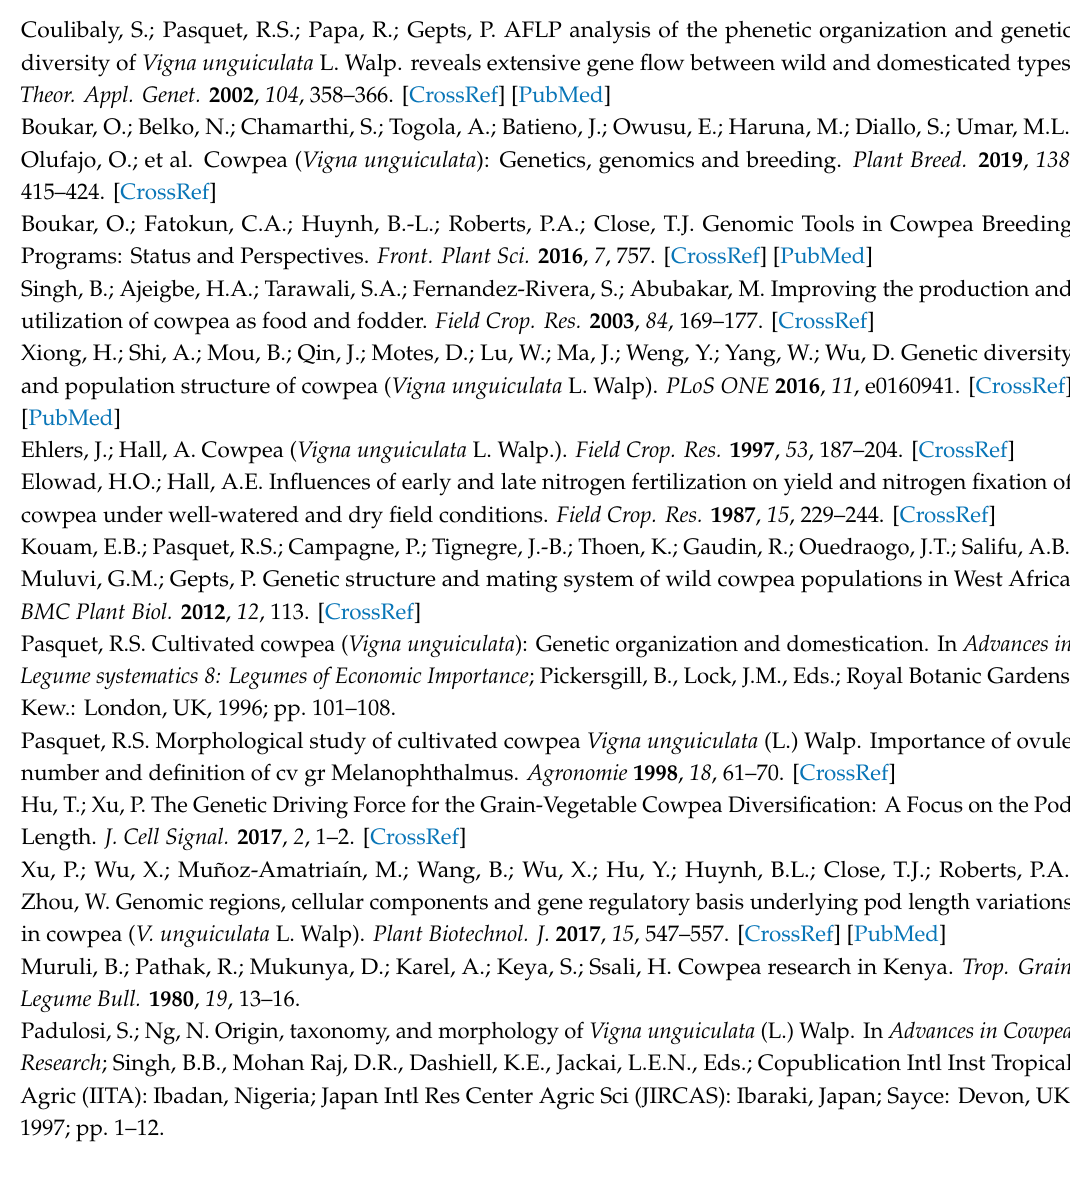
Figure S1: Distribution of the 100-seed weight in the four di ff erent groups based on the population structure of the 376 global cowpea accessions; Figure S2: Distribution of the 100-seed weight in the three di ff erent groups based on the population structure of the 229 Korean cowpea accessions; Table S1: List of the global cowpea accessions and agronomic traits in this study; Table S2: List of the Korean cowpea accessions and agronomic traits in this study; Table S3: Raw data for the genetic diversity statistics of the global cowpea accessions; Table S4: Raw data for the genetic diversity statistics of the Korean cowpea accessions; Table S5: Population structure of the 376 global accessions based on 35,116 SNPs; Table S6: Population structure of the 229 Korean cowpea accessions based on 35,116